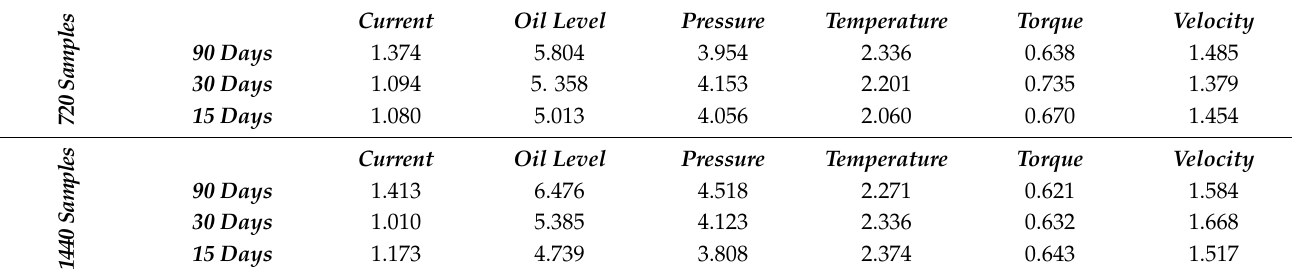
Table 2. Comparative MSE results.